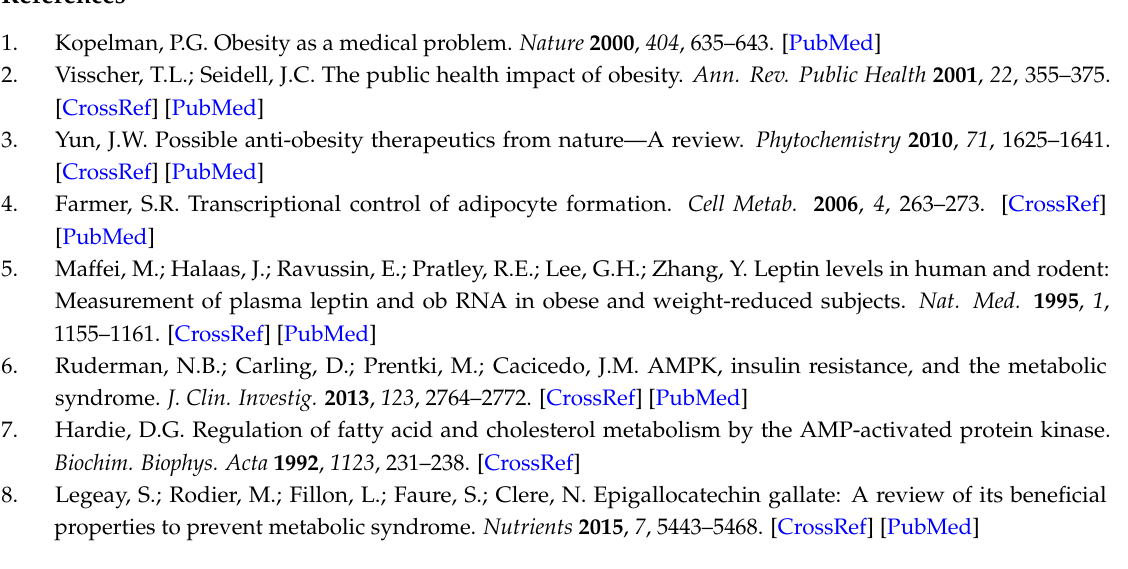
Table S1: Composition of experimental